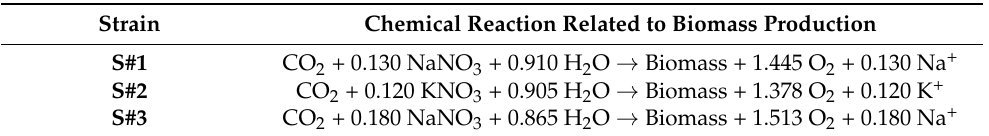
Table 2. Chemical reactions expressing the conversions undertaken during the microalgae production